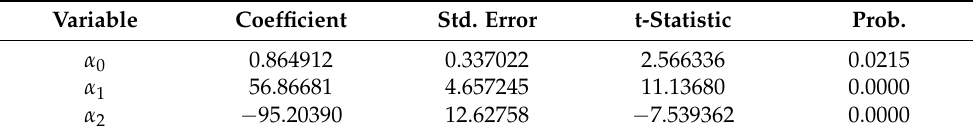
Table 4. Regression results of EKC curve.